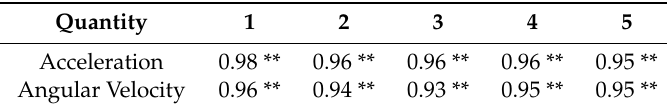
Table 1. The correlation s coefficient from 5 trials.